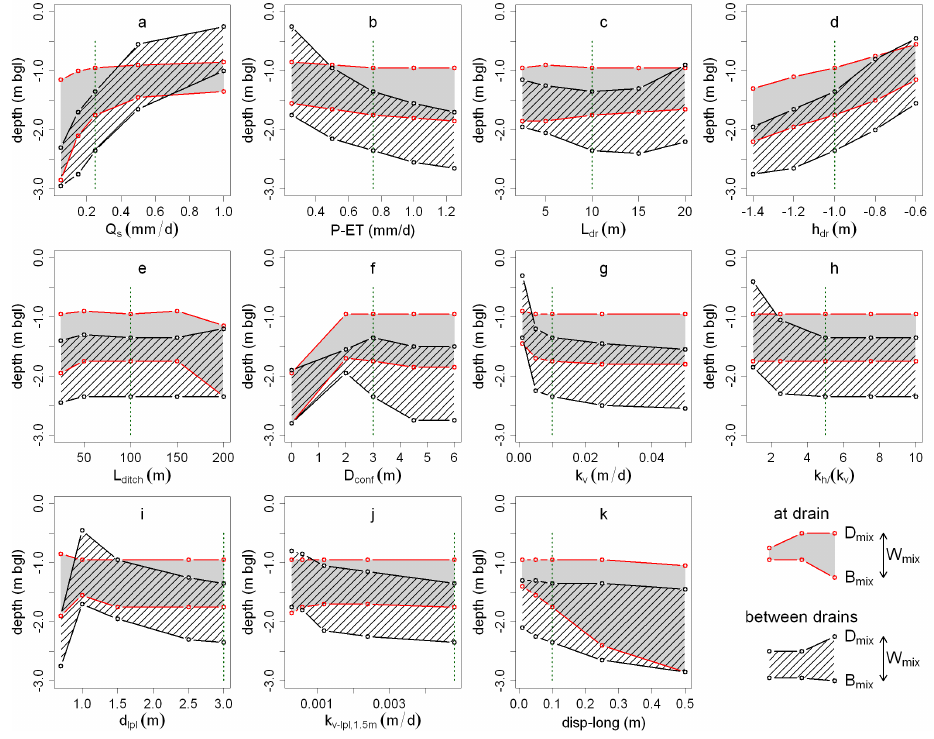
Fig. 12. Results of the sensitivity analysis for the 11 most sensitive parameters for lens characteristics D mix , B mix and W mix (effect > 0.1m). The x-axis gives the parameter values of the reference model and the four sensitivity models; the y-axis gives the position of D mix and B mix for the different models, for a location at a drain and between two drains. The green dotted line indicates the position of the reference